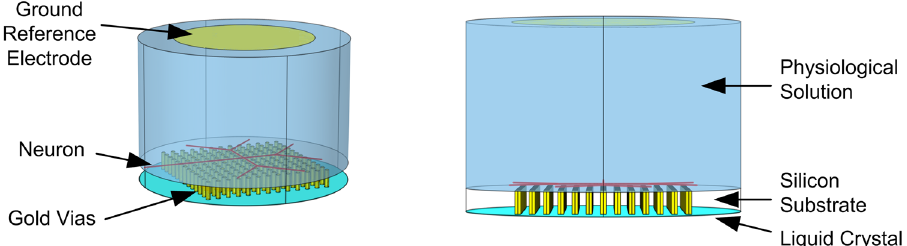
Figure 4. Geoemtry of the optrode device model used for time-domain finite element